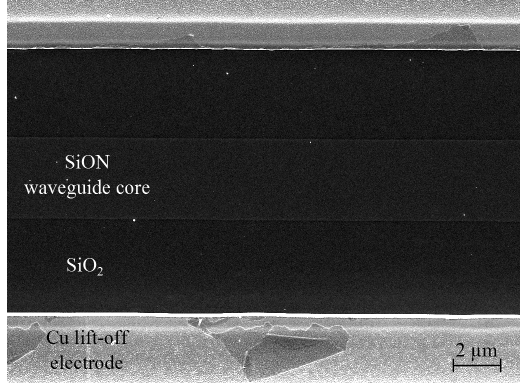
Figure 4. SEM picture of the active region of a fabricated prototype